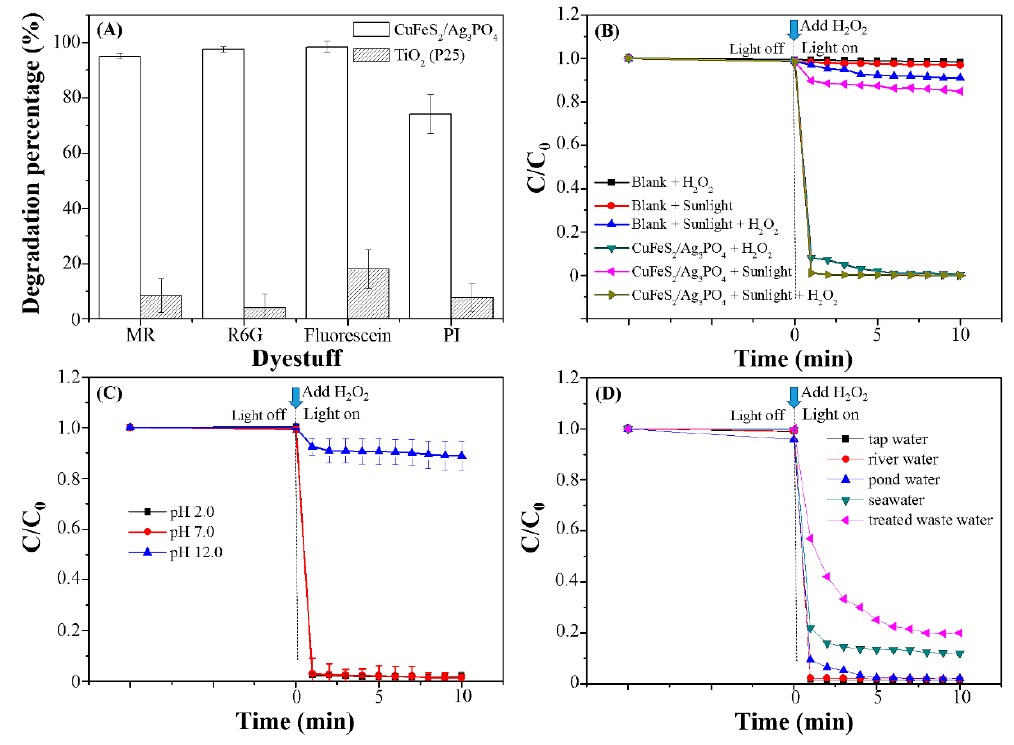
Figure 17. Photo-Fenton reaction of ( A ) different dyestuff by CuFeS 2 /Ag 3 PO 4 composites and P25; ( B ) different degradation procedures in the absence and presence of CuFeS 2 /Ag 3 PO 4 under sunlight irradiation; ( C ) different pH; and ( D ) different environmental water samples for RhB degradation by CuFeS 2 /Ag 3 PO 4 .